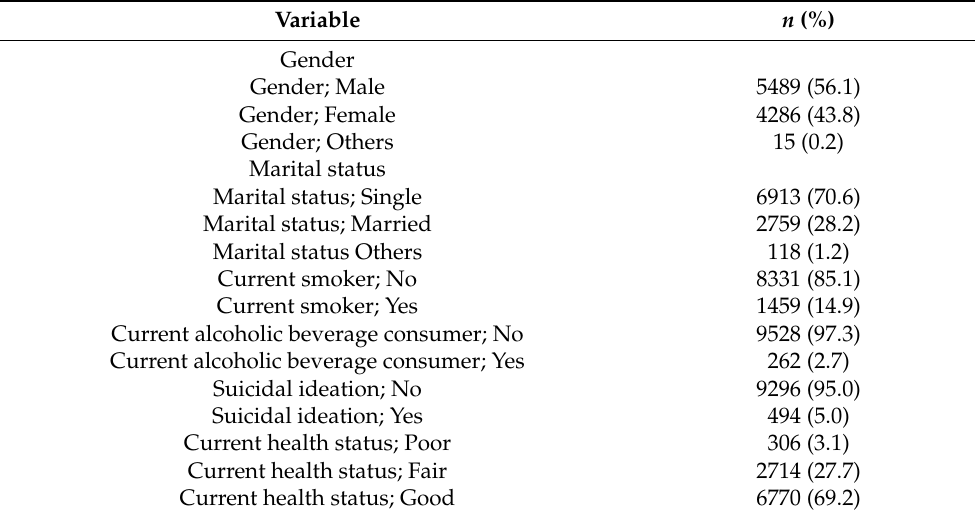
Table 2. Participant characteristics of categorical data in the present sample ( n = 9790).